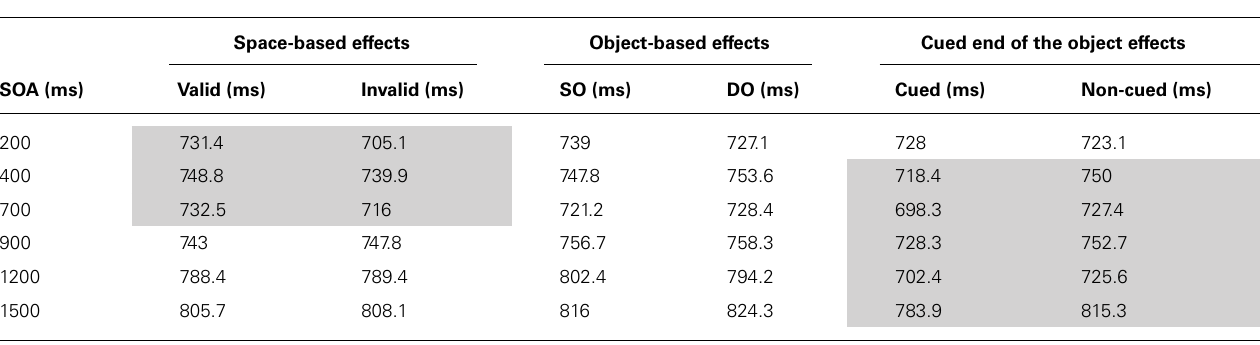
Table 1 | RTs of each comparison for Experiment